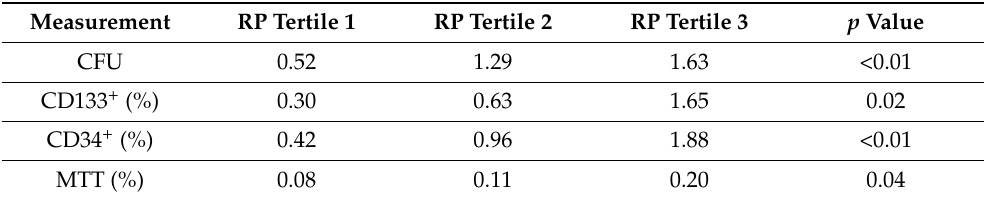
Table 3. Rates of EPC by RP Tertiles.